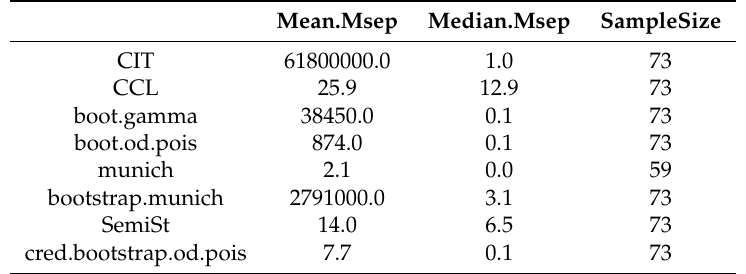
Table 15. Mean square error of prediction from the private passenger auto liability